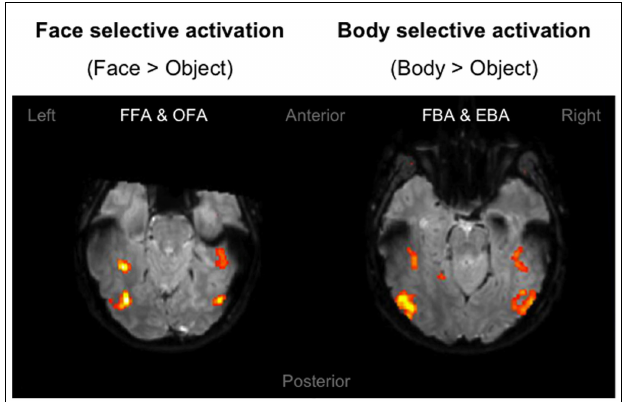
FIGURE 3 | Localizer activation maps of face and body selective clusters. Examples of activation maps of face and body selective clusters as defined by the independent localizer, displayed on axial functional image slices.The clusters were defined by contrasting the BOLD signal associated with the presentation of faces and bodies compared to objects. Contrasts were calculated using t -tests with family-wise error (FWE) corrections for multiple comparisons ( p < 0.05).